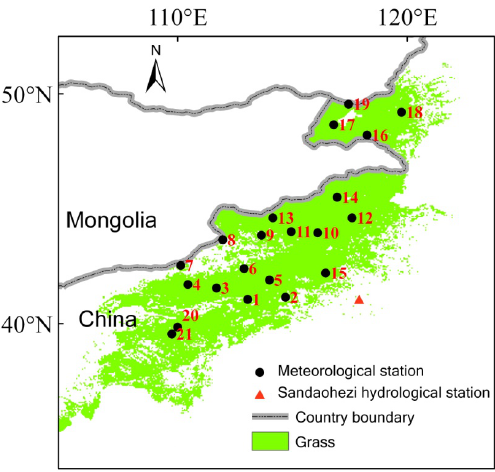
Fig. 1. Study area and gauging stations. 2